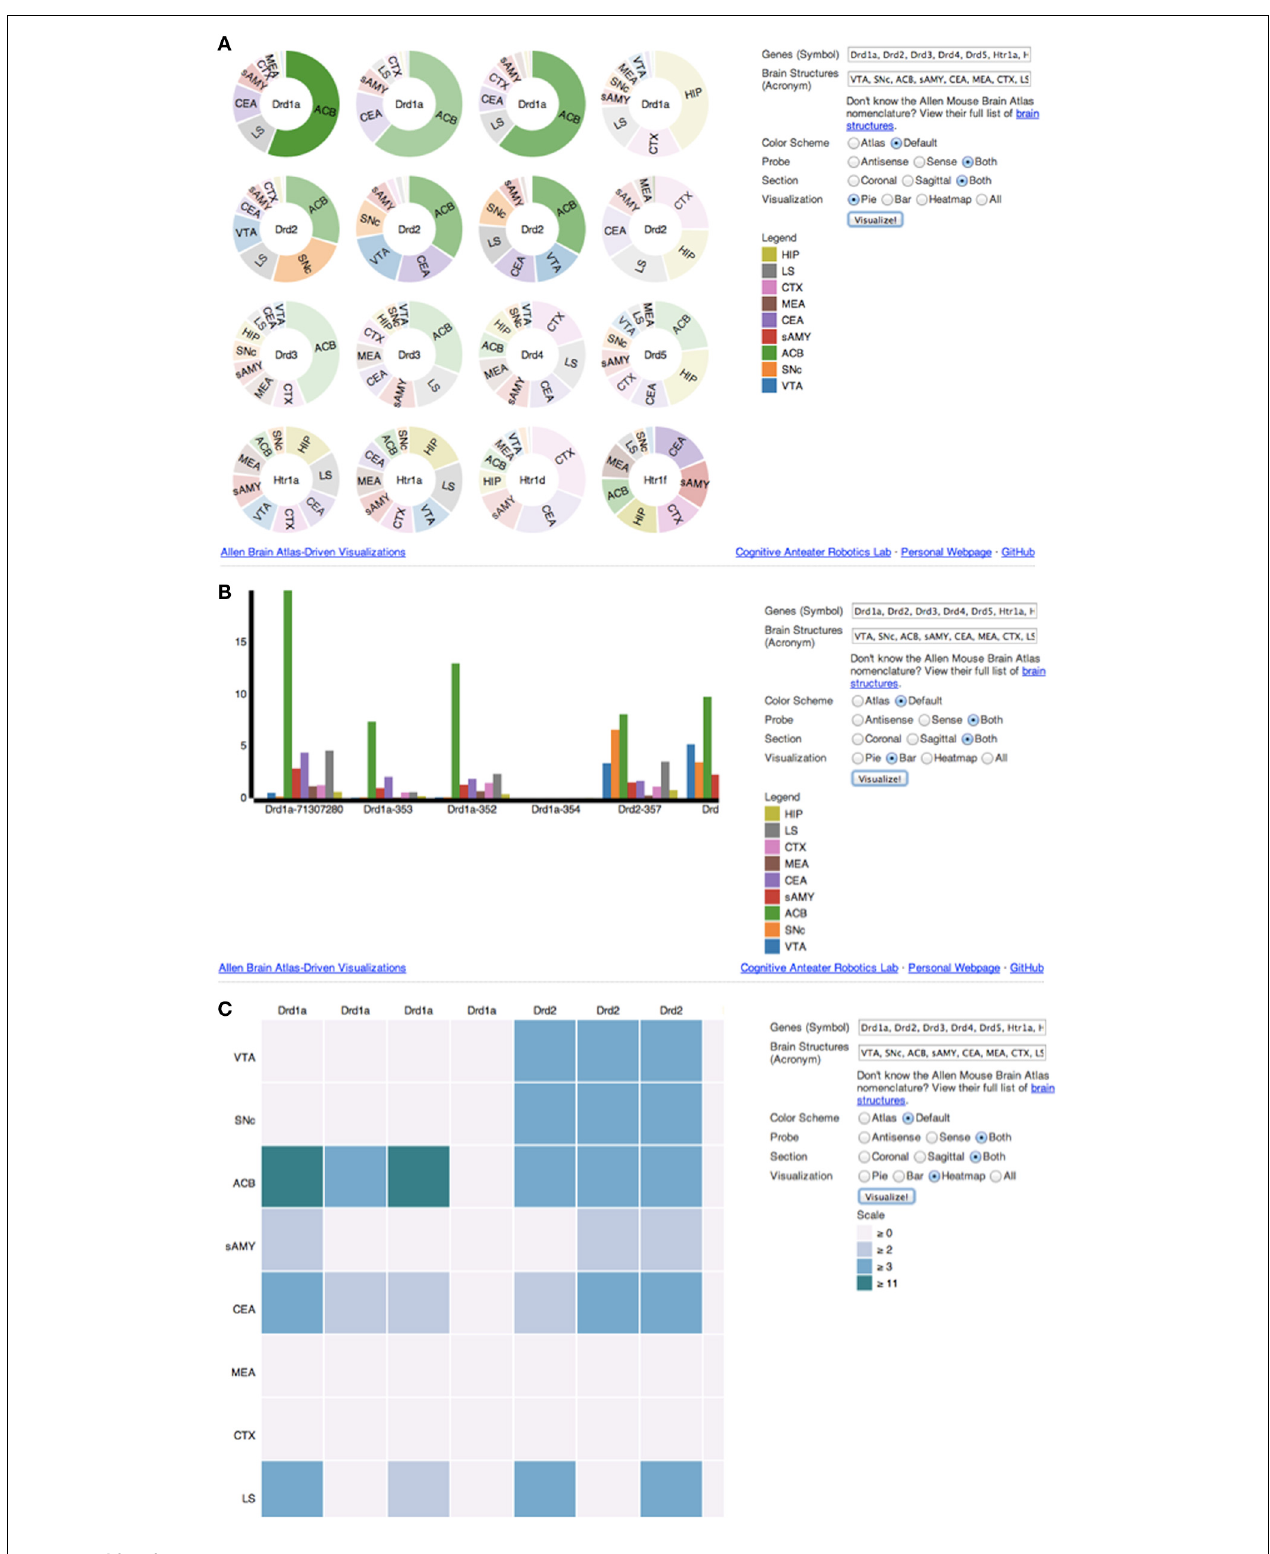
FIGURE 3 | (A–C) Screenshot of ABADV Visualizations. A screen capture of each visualization page for ABADV. Users can select different filters and type in a list of genes and brain structures of interest. Depending on the visualization,